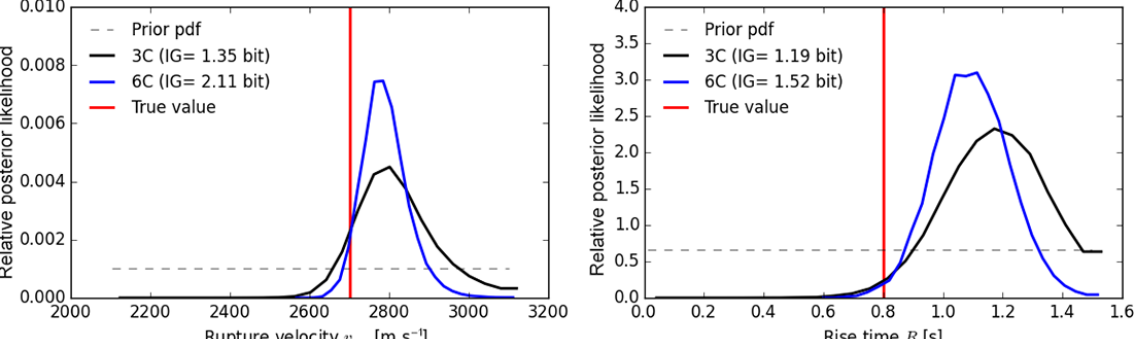
Figure 7. Inversion results for rupture velocity v rup (left) and rise time R (right) for a dip-slip fault. The prior pdf is shown as a black dashed line, the true value as a vertical red line, and the posterior pdf for the 3C inversion as a black line and for the 6C inversion as a blue line. The information gain increased with incorporation of rotation rate data by 56 . 02% for inverting for rupture velocity and by 28 . 47% increase for rise time. Here, in contrast to Fig. 5, the true values are captured better by the 6C inversion than by the 3C